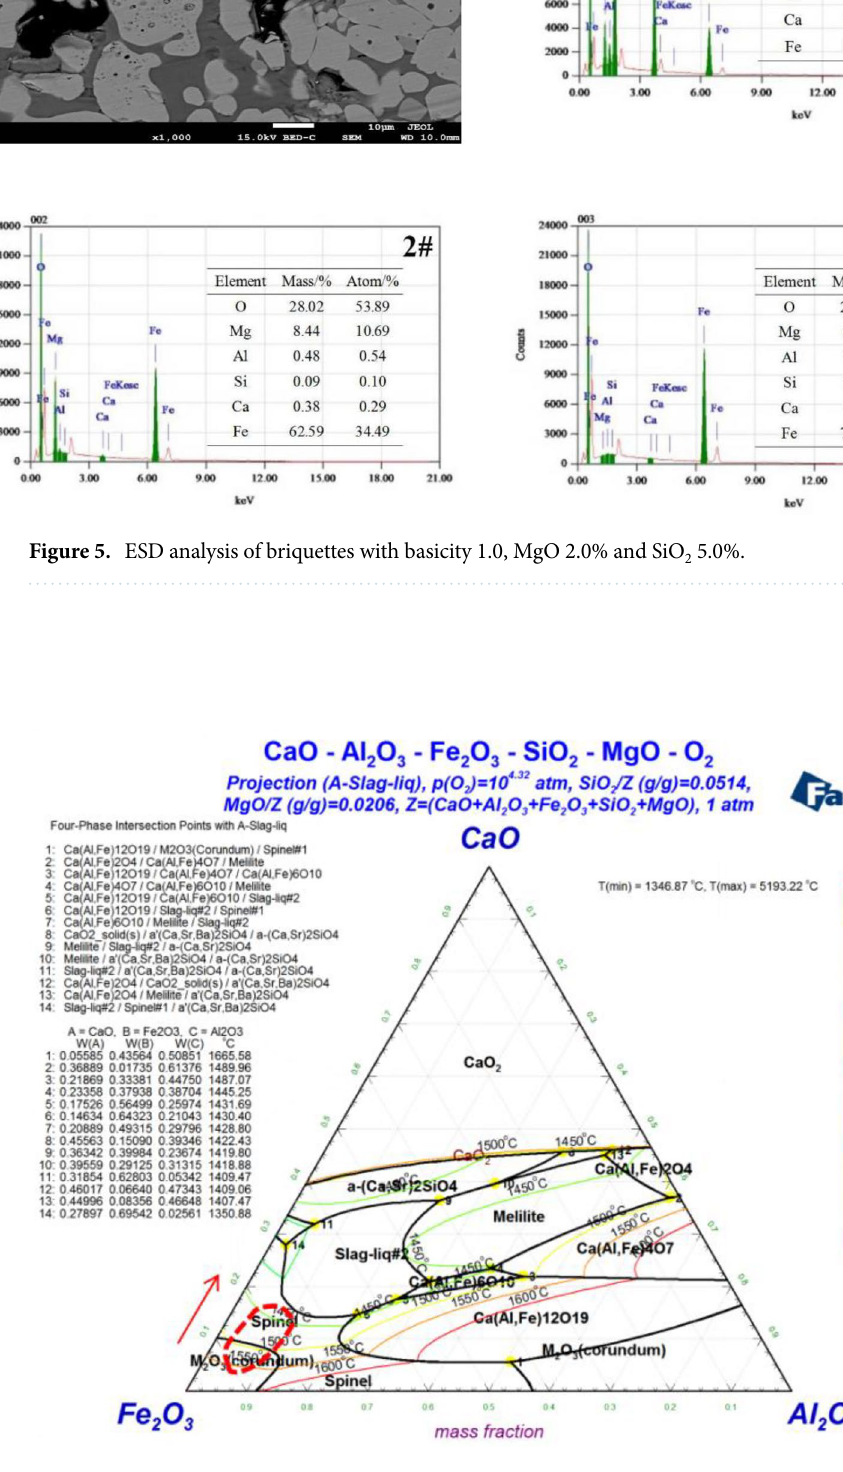
Figure 6. Phase diagram of CaO-Al 2 O 3 -Fe 2 O 3 -5wt%SiO 2 -2wt%MgO (calculated by FactSage